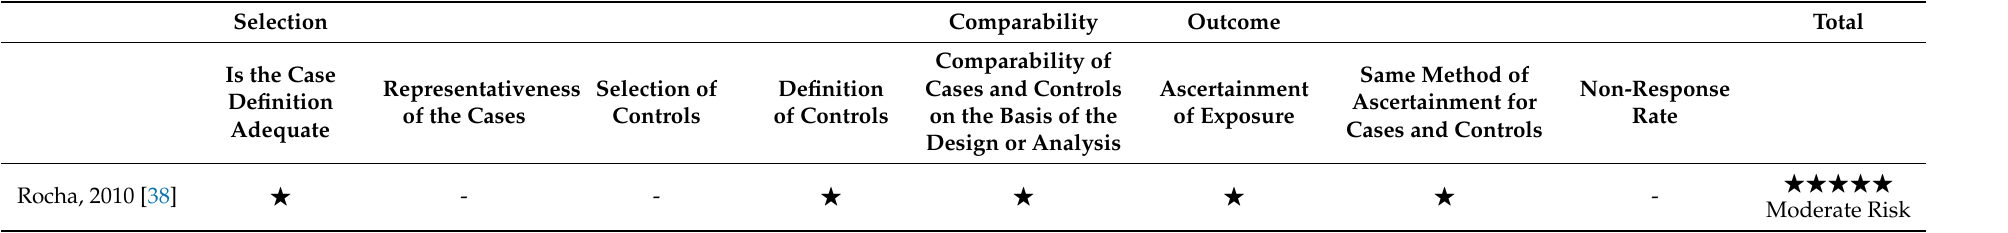
Table 2. Newcastle Ottawa Scale: CASE CONTROL